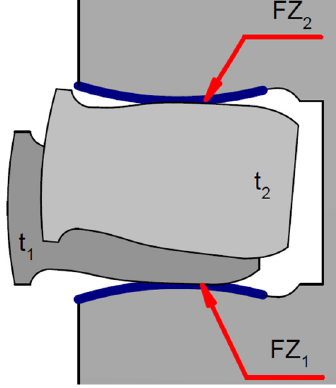
Figure 2. Wear of the piston ring and piston shelf as a result of their cooperating, where: t 1 —ring position relative to the piston groove shelf at time t 1 ; FZ 1 —friction zone (ring—lower shelf) at time t 1 ; t 2 —ring position relative to the piston shelf at time t 2 ; and FZ 2 —friction zone (ring—lower shelf) at time t 2 .